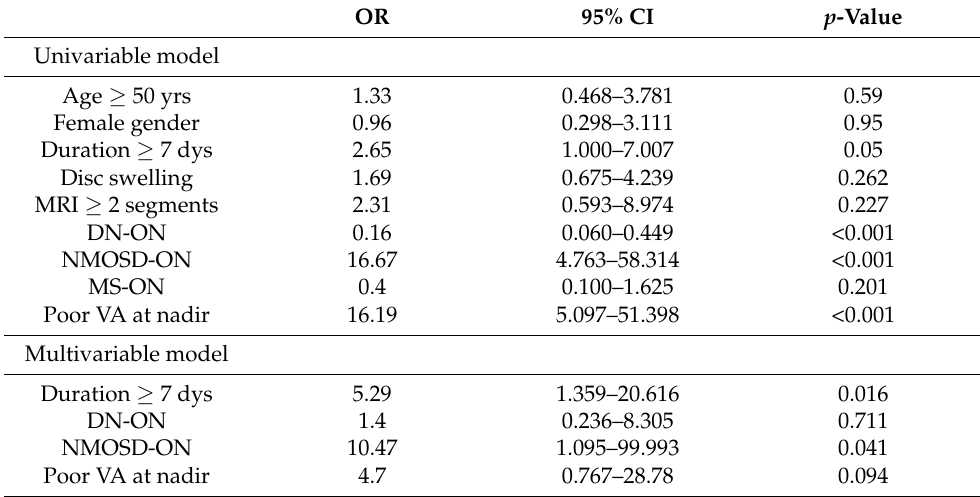
Table 4. Logistic-regression analysis of factors predicting visual outcome at